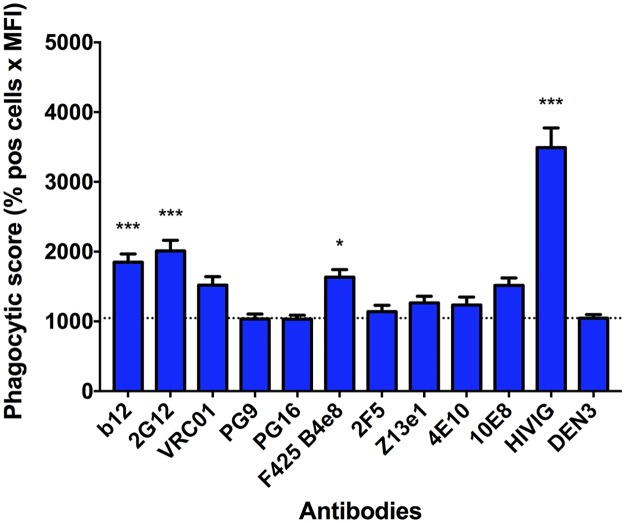
CEM.NKr-CCR5 cells decorated with HIV-1iGFP/JR-FL are targets for ADP or trogocytosis by Env-specific antibodies.HIV-1iGFP/JR-FL virions were spinoculated onto CEM.NKr-CCR5 target cells at 4°C, which were then opsonized with HIV-specific antibodies. THP-1 effector cells (effector:target ratio = 1:1) were next incubated with the target cells for one hour. The THP-1 cells were identified by PE-conjugated anti-CD32 staining, and double positive (PE+/GFP+) cells were analyzed using flow cytometry. Antibodies were tested at a concentration of 0.05 mg/mL and the polyclonal antibody HIVIG at a concentration of 0.2 mg/mL. Data are represented as phagocytic score (% positive cells x MFI). Note that these methods do not distinguish whether target cells themselves are internalized (phagocytosis) or whether membranes containing virus are internalized (trogocytosis). One-way ANOVA was used to analyze differences compared with the no antibody control (dotted line), after demonstrating a normal data distribution. P-values are indicated with an asterisk: * p ≤ 0.05; ** p ≤ 0.01, and *** p ≤ 0.001. Experiments were performed in triplicates and repeated at least four times. Data are means + S.E.M.